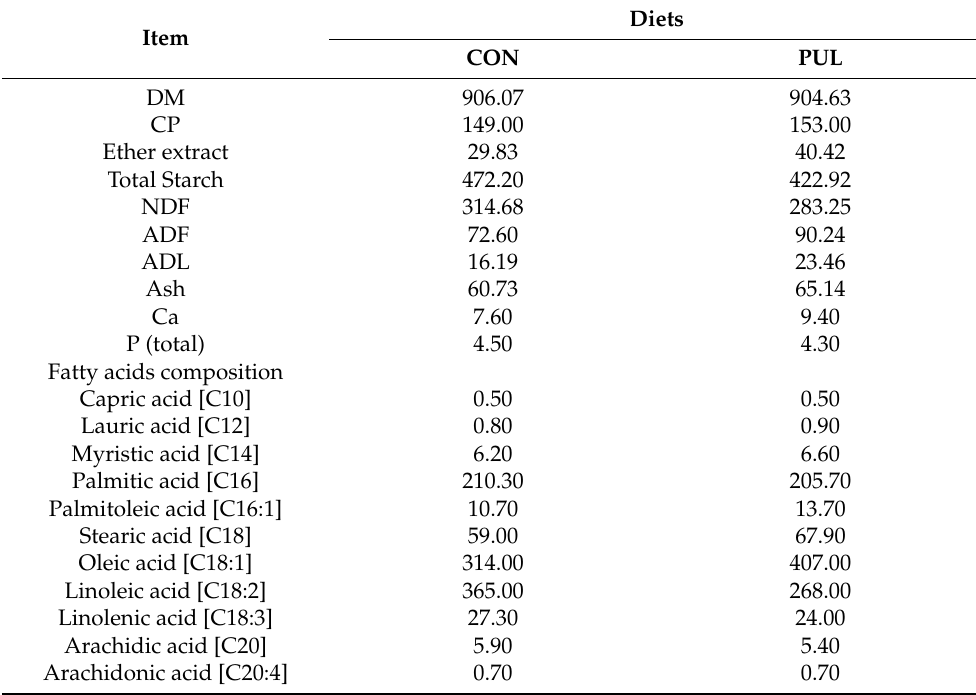
Table 2. Analyzed nutrient composition (g/kg, on a dry matter basis) and fatty acids profile (g/kg of fat) of diets for Iberian